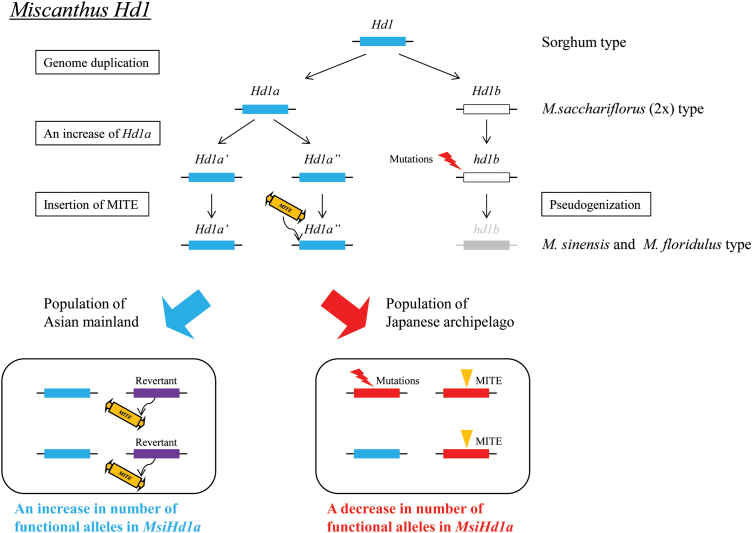
Schematic model for Miscanthus Hd1 evolution. Blue indicates functional alleles and red indicates non-functional alleles. The whole genome duplication of Miscanthus resulted in Hd1a and Hd1b loci. Accumulation of deleterious mutations caused pseudogenization of Hd1b in M. sinensis. By additional local duplication, Hd1a increased in copy number (duplicated genes designated as Hd1a’ and Hd1a’’ in figure). After the last glacial maximum, the number of functional Hd1a alleles in the Asian mainland population of M. sinensis was high, whereas, in the Japanese population, the number of functional alleles decreased due to the accumulation of alleles with MITE insertions and/or other deleterious mutations. This difference suggests that dependency on the gene function of Hd1a is different between M. sinensis populations from the Asian mainland and the Japanese archipelago.